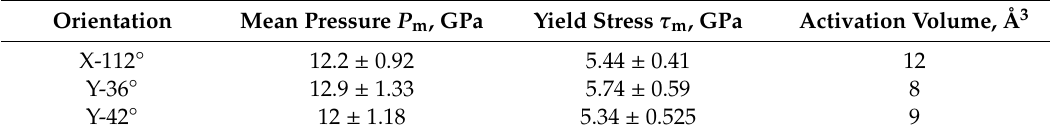
Figure 3. The values of maximum pressure stress P m at the onset of first pop-in versus measurements for ( a ) X-112° plane, ( b ) Y-36° plane, and ( c ) Y-42° plane; ( d ) Cumulative distribution of P m for the three planes. Table 1. Mean pressure, yield stress, and activation volume for three